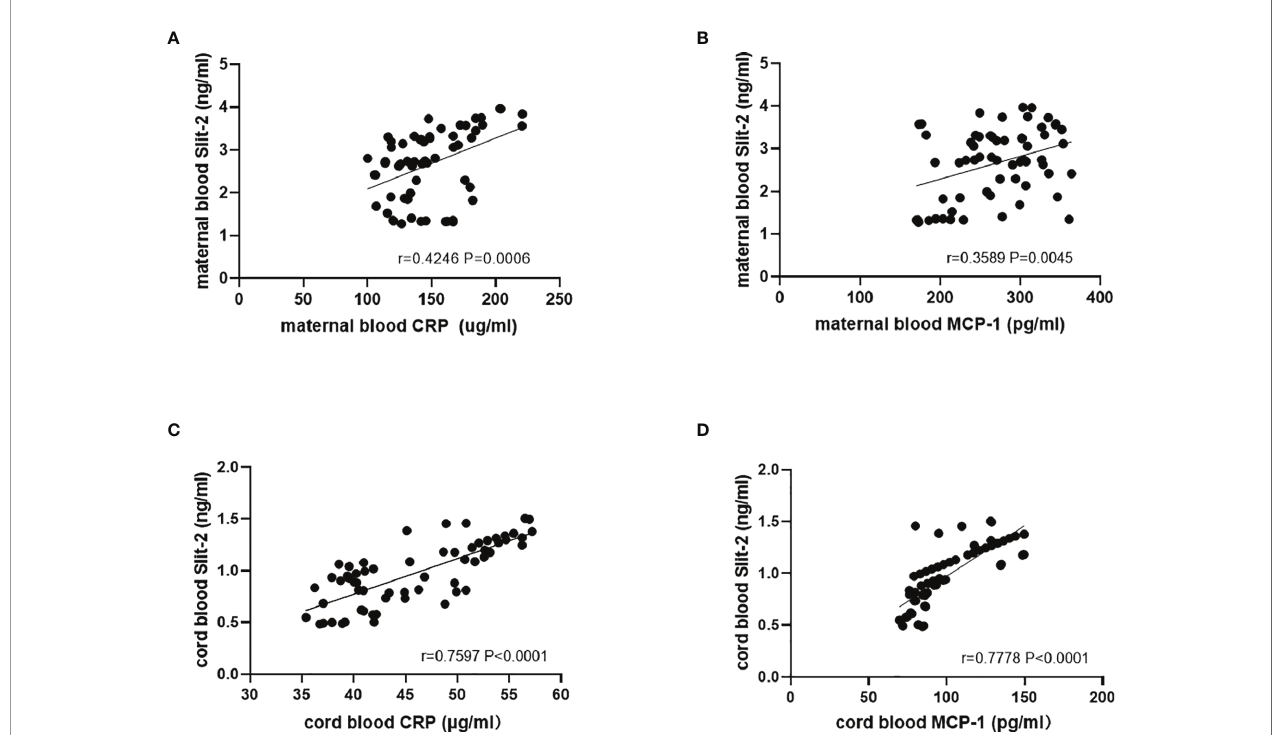
FIGURE 2 | Relationship between the Slit-2 level and CRP and MCP-1 in maternal peripheral blood and neonatal cord blood of patients with GDM. (A) Relationship between the Slit-2 level and CRP in maternal peripheral blood of the patients with GDM. (B) Relationship between the Slit-2 level and MCP-1 in maternal peripheral blood of the patients with GDM. (C) Relationship between the Slit-2 level and CRP in neonatal cord blood of the patients with GDM. (D) Relationship between the Slit-2 level and MCP-1 in neonatal cord blood of the patients with GDM. Slit-2, Slit guidance ligand 2; CRP, C-reactive protein; MCP-1, monocyte chemoattractant